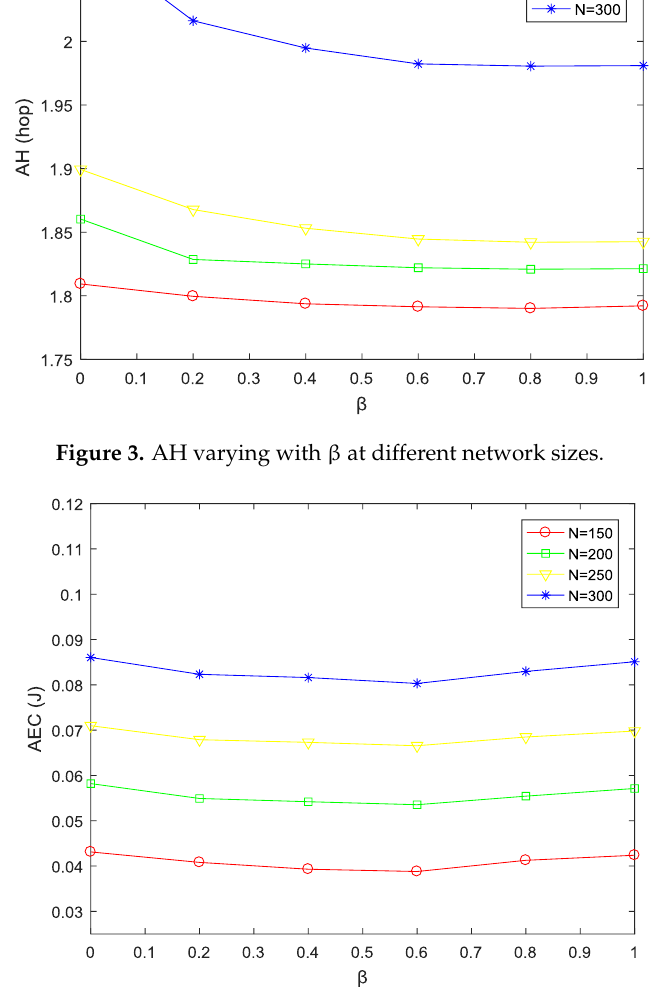
Figure 4. AEC varying with β at different network sizes.